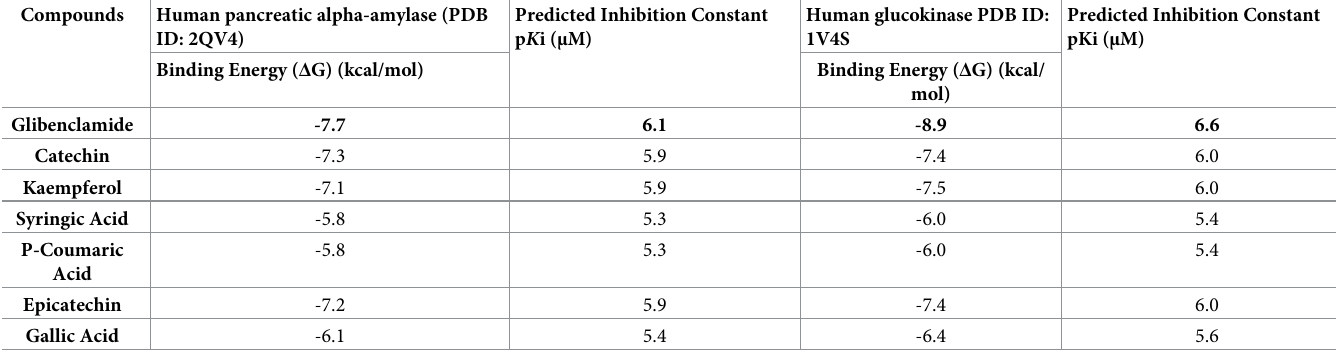
Table 6. In silico molecular docking results of GLB and bioactive phytochemicals interaction with antidiabetic receptors. Compounds Human pancreatic alpha-amylase (PDB ID: